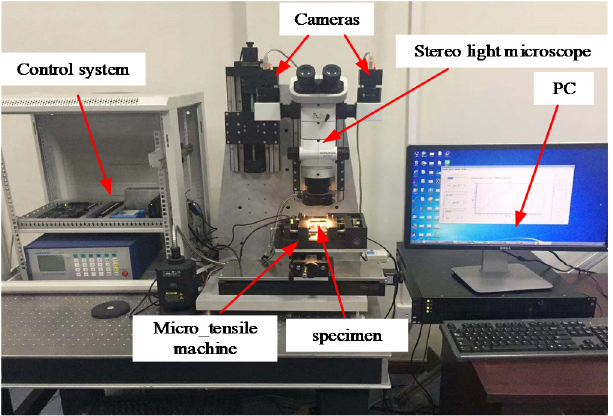
Figure 1. Testing system for investigating the mechanical properties of small-scale specimens based on 3D microscopic digital image correlation. 3D microscopic digital image